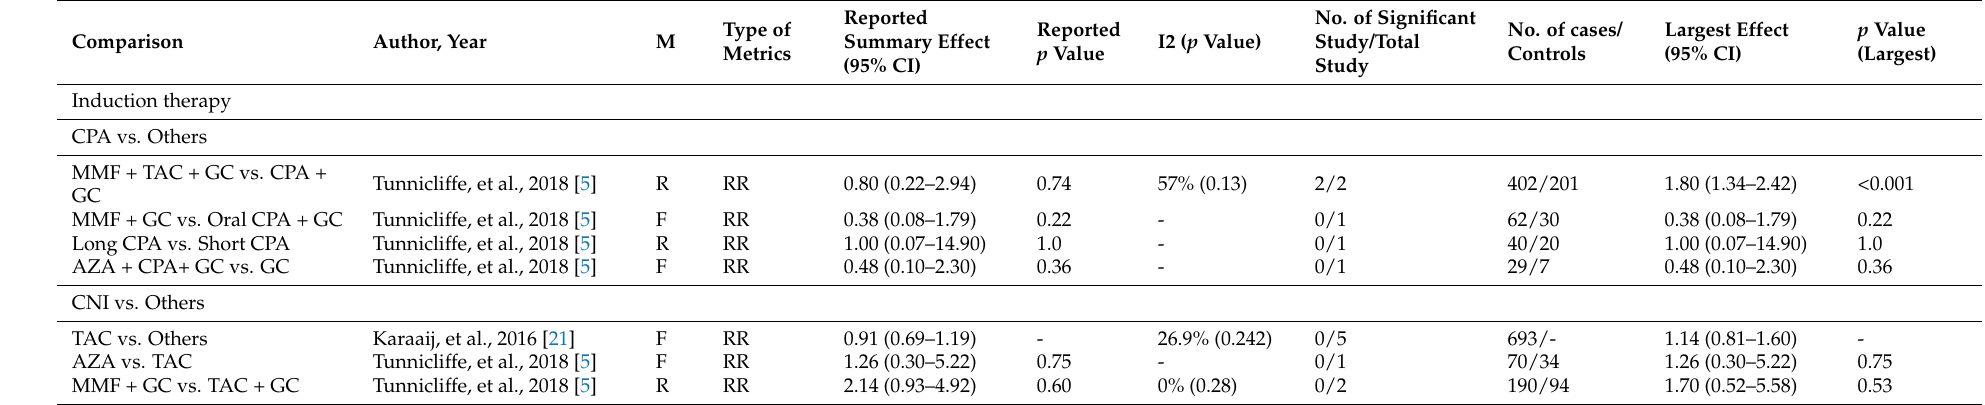
Table 12. Infection during induction and maintenance therapy in lupus